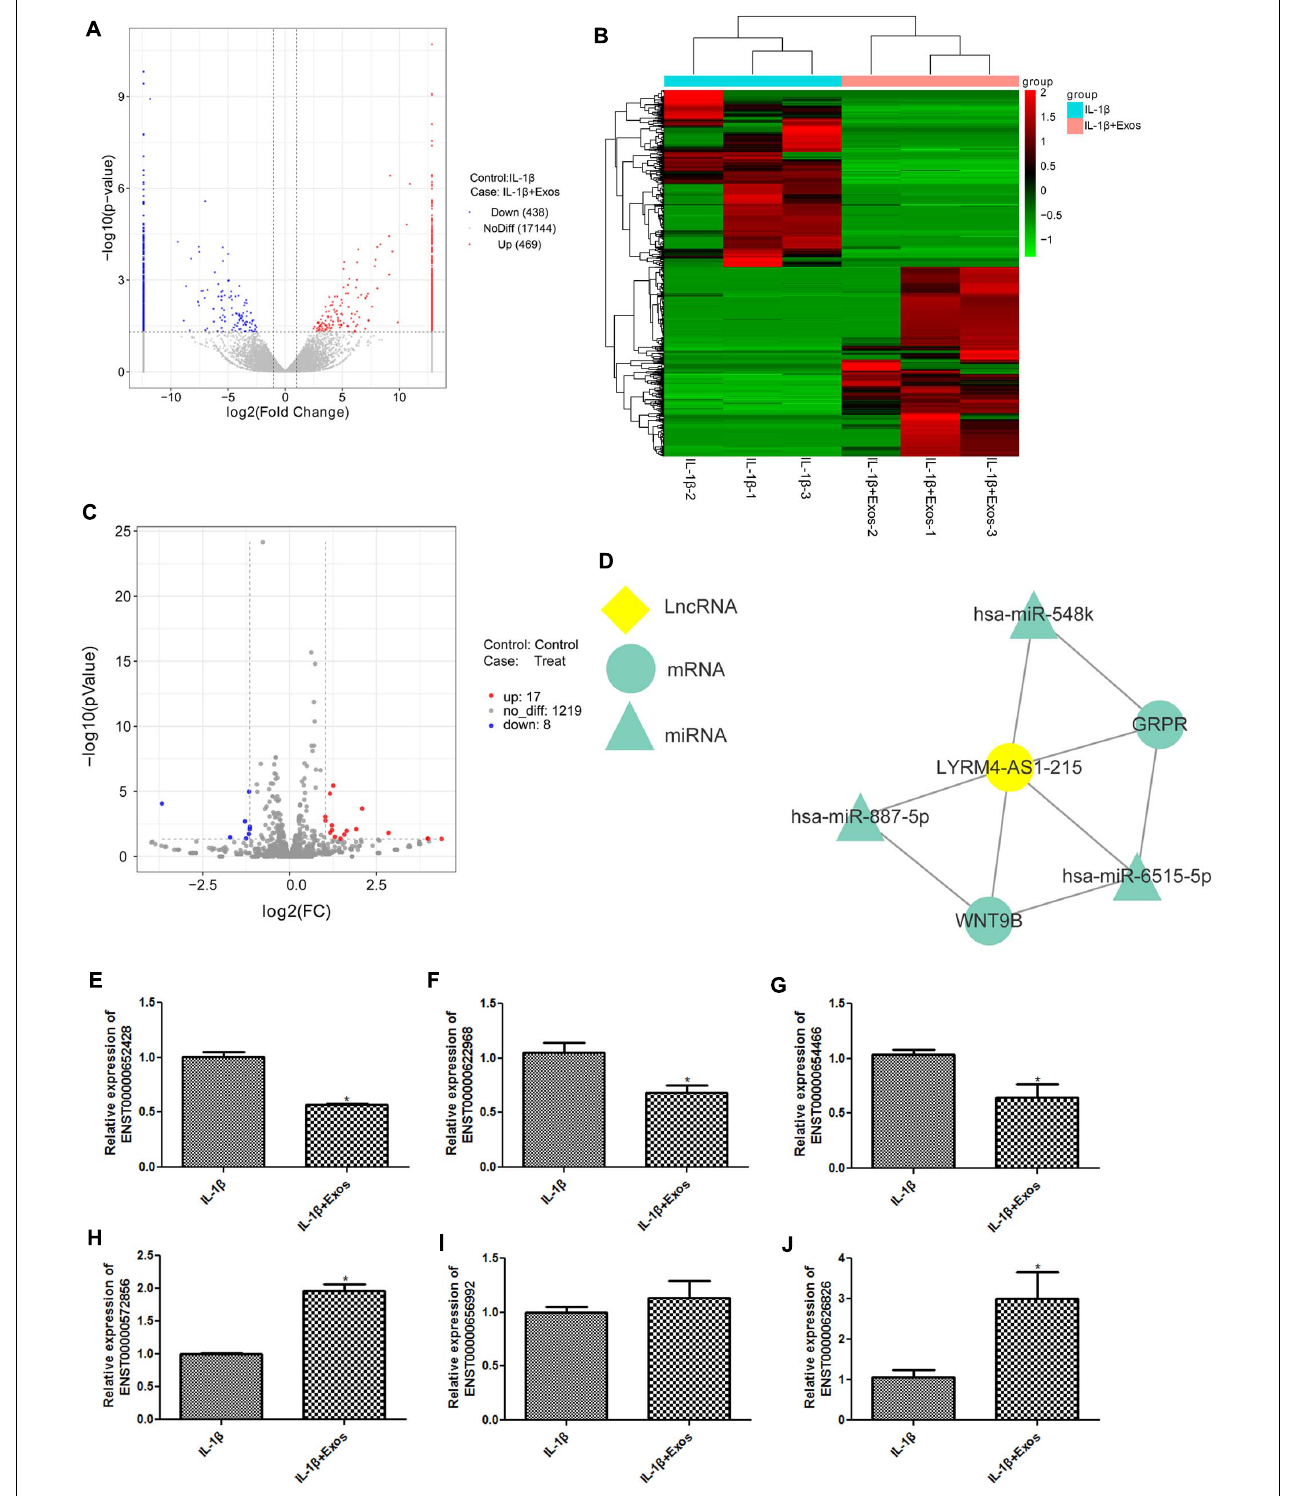
FIGURE 4 | (A) The volcano plot of differentially expressed lncRNAs (DE-lncRNAs). (B) The heat map of DE-lncRNAs. (C) The volcano plot of differentially expressed miRNAs (DE-miRNAs). (D) A ceRNA network about lncRNA LYRM4-AS1 was built. (E) The expression of lncRNA ENST00000652428. (F) The expression of lncRNA ENST00000622968. (G) The expression of lncRNA ENST00000654466. (H) The expression of lncRNA ENST00000572856. (I) The expression of lncRNA ENST00000656992. (J) The expression of lncRNA ENST000006268268. n = 3. * P < 0.05 vs. IL-1 β group.